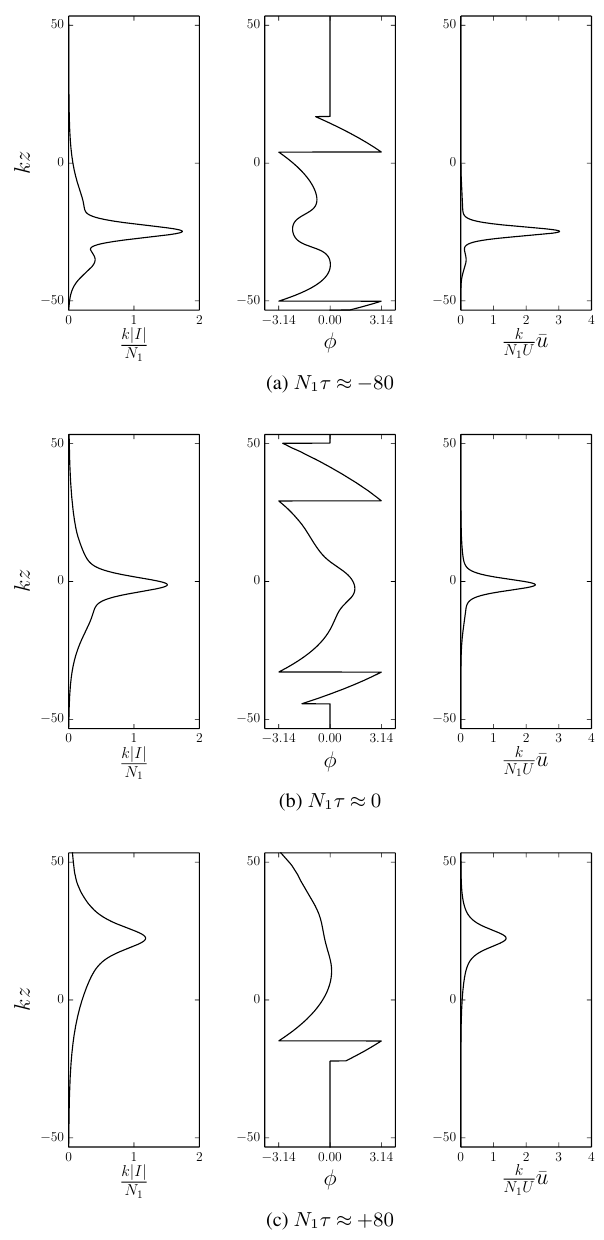
Figure 4. Vertical profiles of the wave magnitudes A (left panel), phases φ (center panel), and mean flow (right panel) at three times in a single layer of constant N with n 1 /k = 0.4, (cid:15) = 0.025, and α =